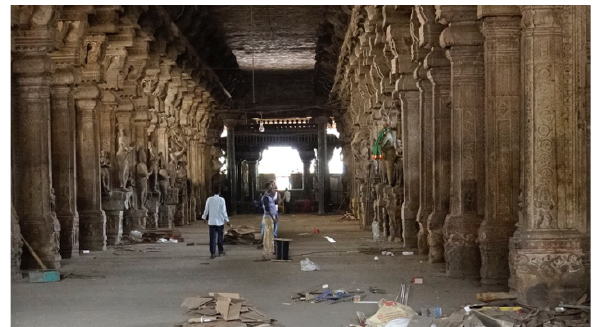
Figure 9. Photograph of interior of Pudu Mandapam, August